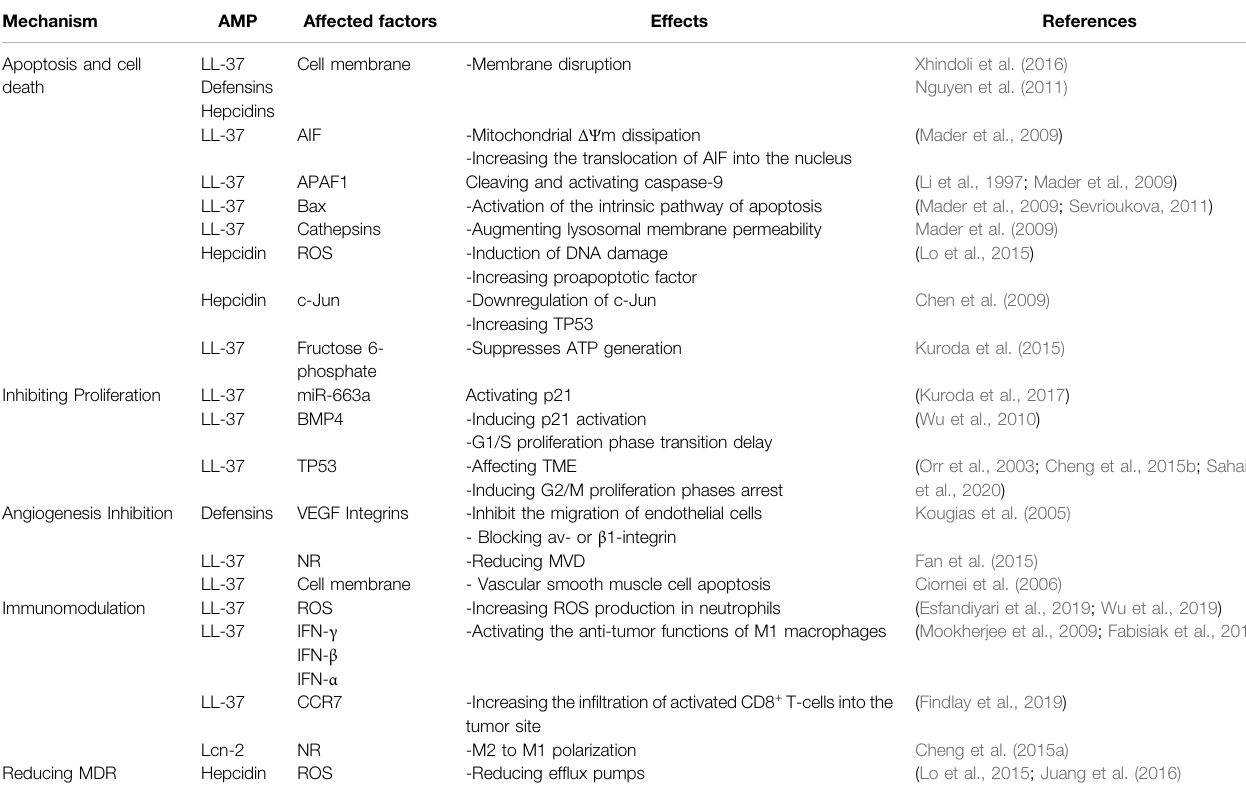
TABLE 2 | Anti-neoplastic effects of MSC-derived